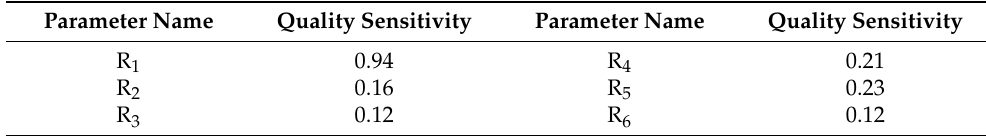
Table 2. Sensitivity analysis of mass to plate thickness.